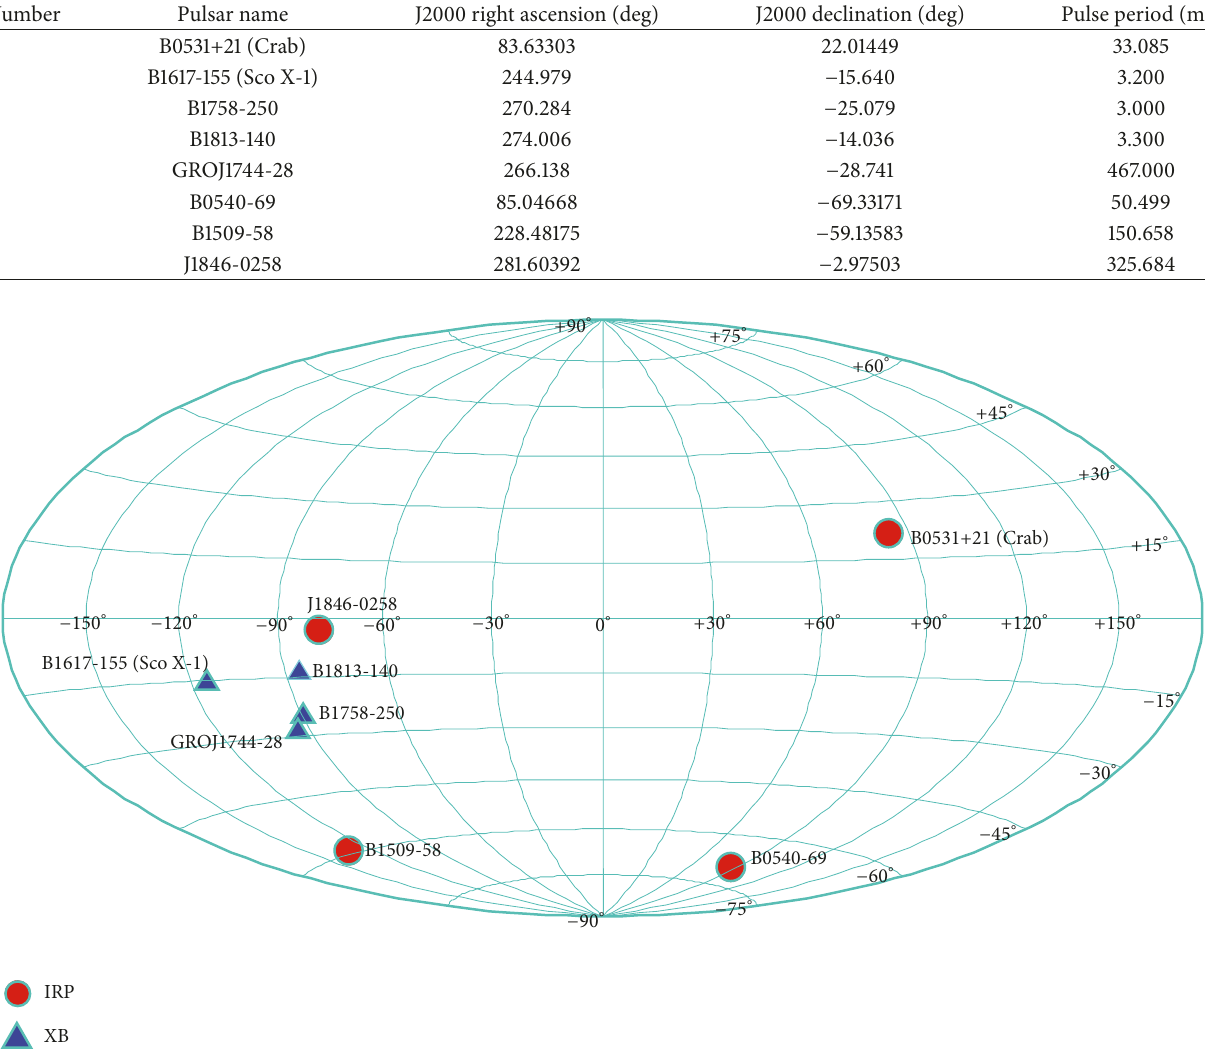
Figure 1: Default targets’ angular positions plotted in the J2000